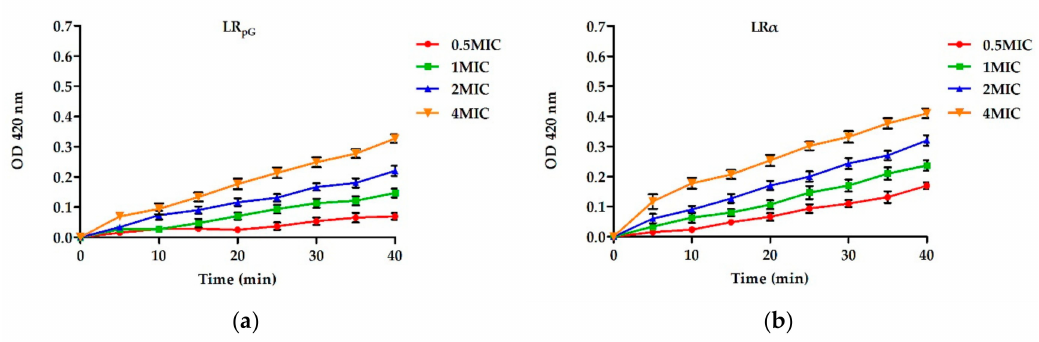
Figure 4. Inner membrane permeability of ( a ) LR pG and ( b ) LR α at di ff erent concentrations. The diagrams are based on at least three independent